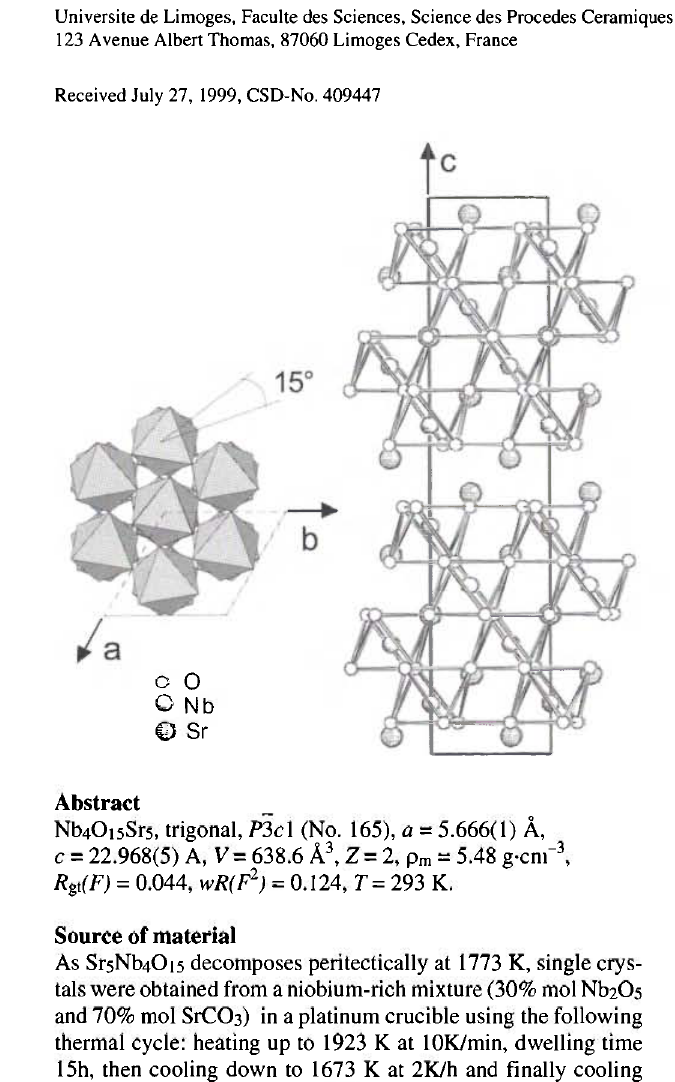
Table 2. Atomic coordinates and displacement parameters (in Ä 2